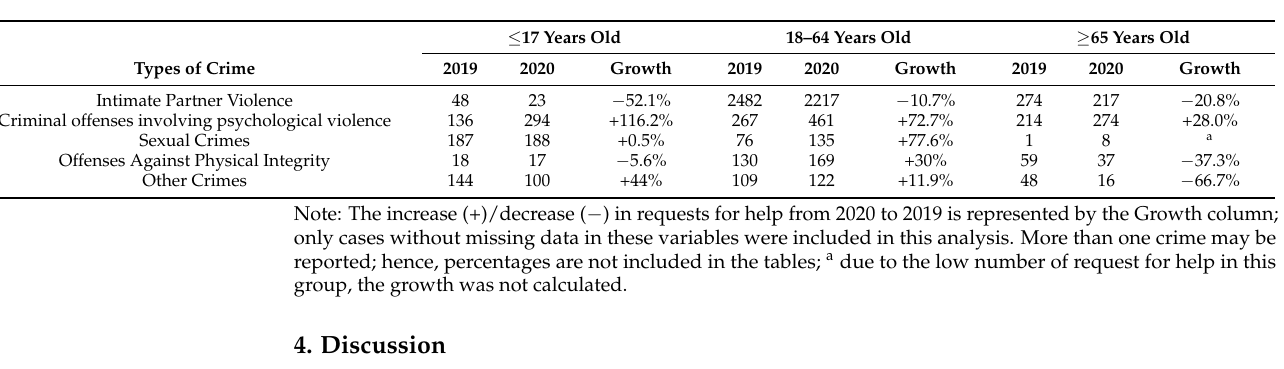
Table 4. Types of crime reported in requests for help during 2019 and 2020 by age